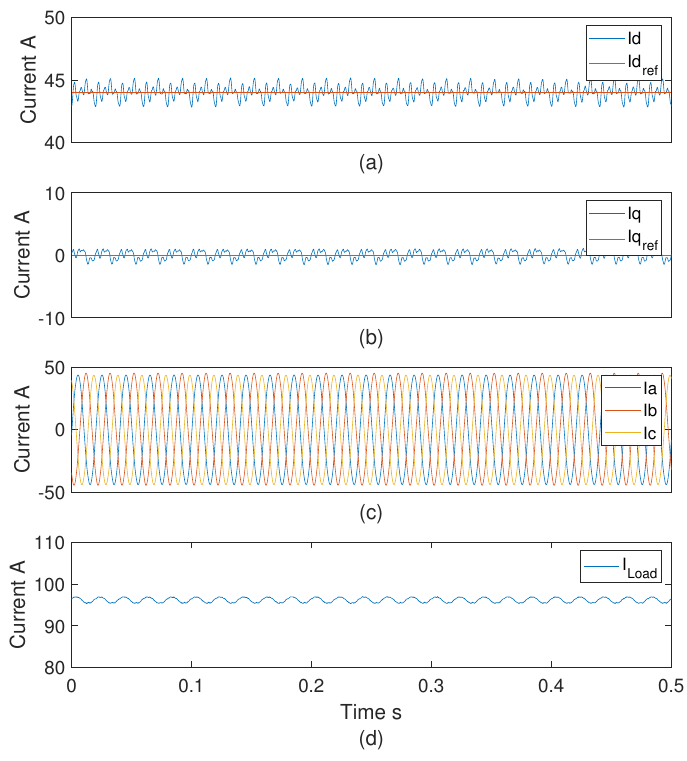
Figure 13. Experimental Results. ( a ) AC d -axis current. ( b ) AC q -axis current. ( c ) AC abc currents. ( d ) DC load